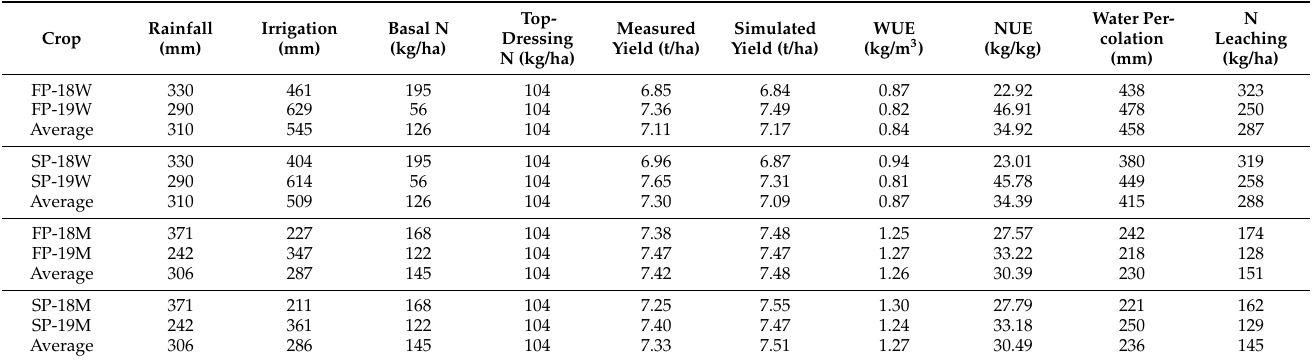
Table 3. The seasonal performance for wheat and maize under farmers’ practice (FP) and split top-dressing practice (SP) in the period